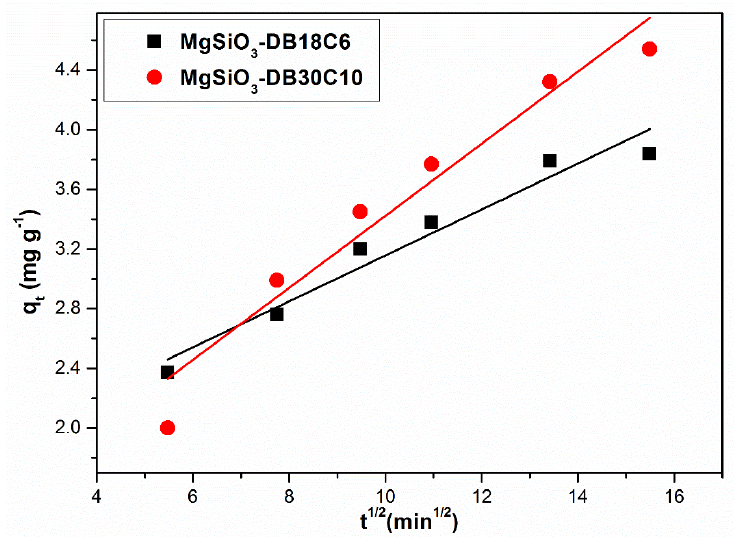
Figure 11. Intraparticle